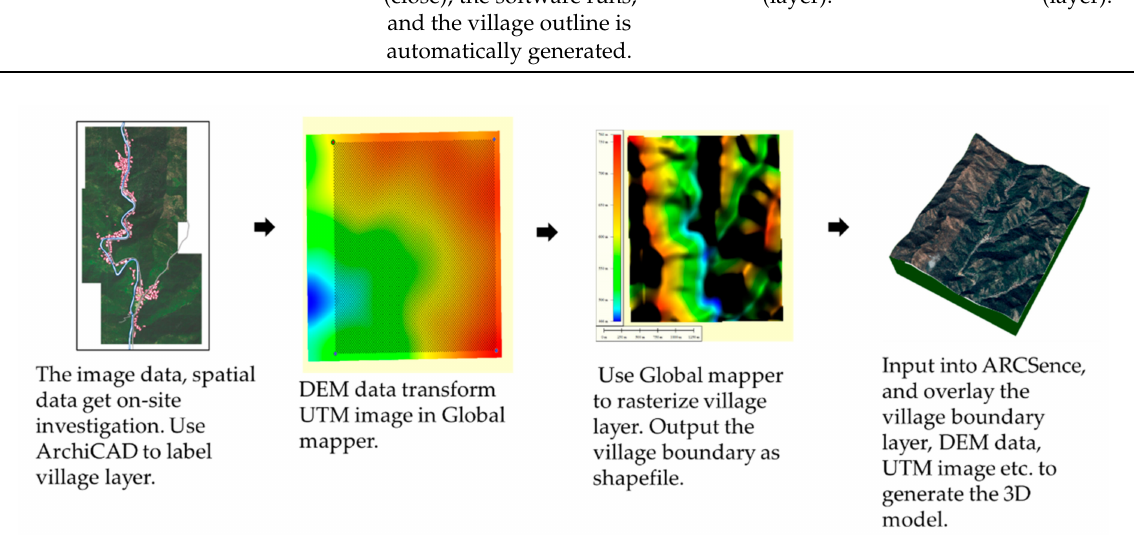
Figure 4. The process to generate village 3D model: edited by